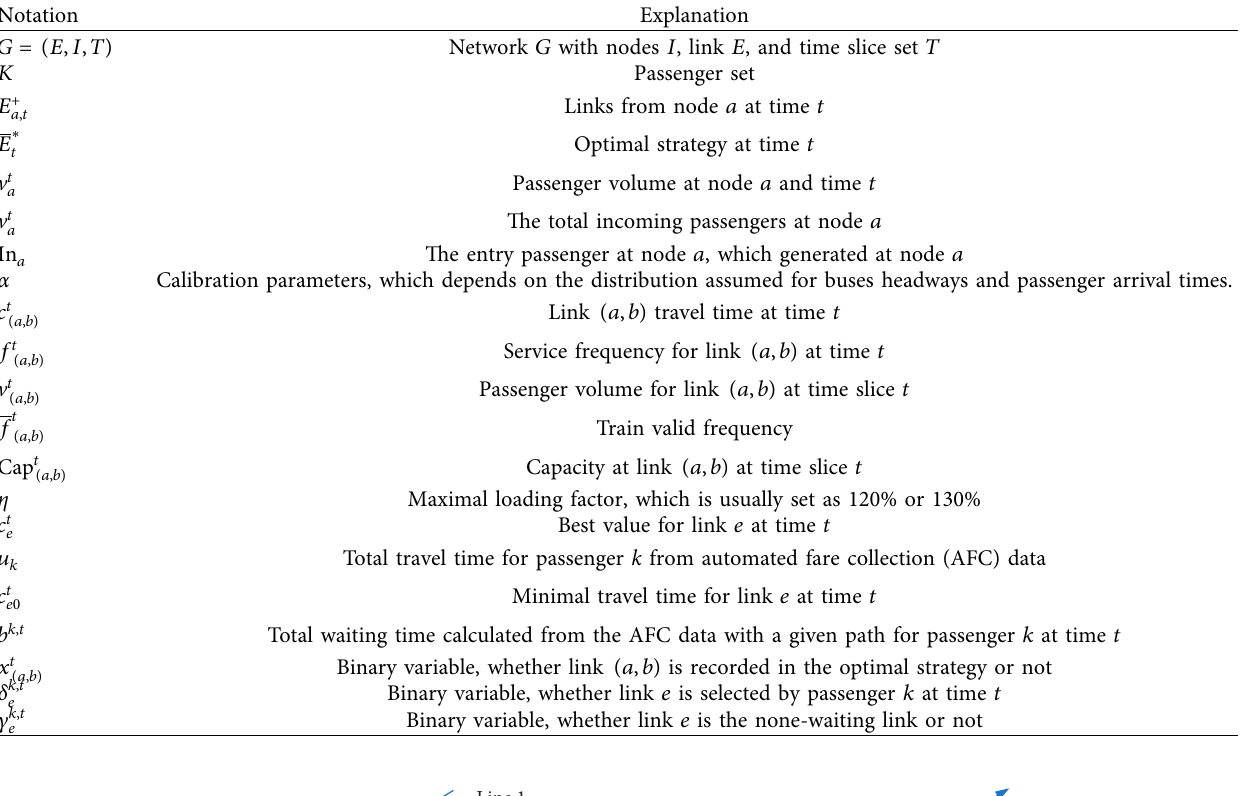
Table 1: Notations used in this study.